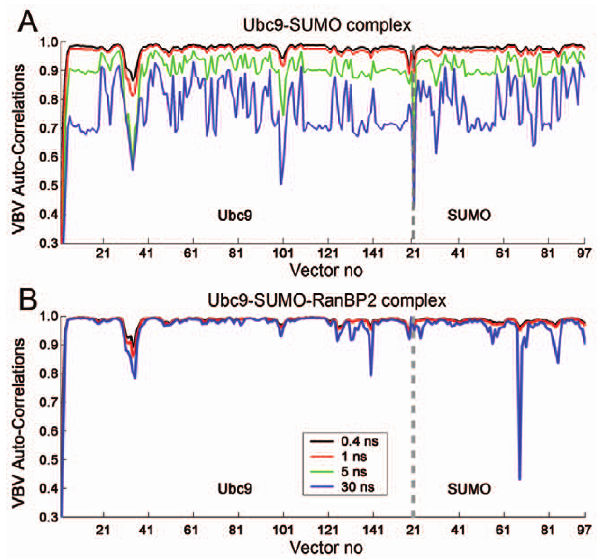
Figure 6. Auto-correlations of the backbone bond vectors (virtual bond vectors between successive alpha carbons). (A) The auto-correlations for Ubc9-SUMO-RanBP2 complex with time delay of 0.4 ns (black), 1 ns (red) and 30 ns (blue). (B) The auto-correlations for Ubc9-SUMO complex with time delay of 0.4 ns (black), 1ns (red), 5 ns (green) and 30 ns (blue). At time delay of 30 ns, there is overall loss of correlations in Ubc9-SUMO complex in comparison to the high correlations observed for Ubc9-SUMO-RanBP2. The correlations with 5 ns delay present first regions to loose correlations as around vector 30 and vector 101 of Ubc9.